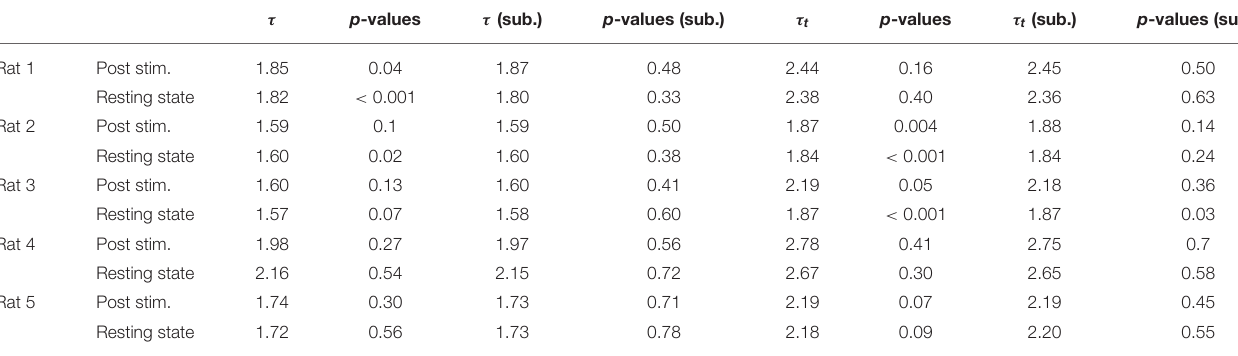
TABLE 2 | Exponents before ad after subsampling in MUAs data, with the corresponding p -values. τ p -values τ (sub.) p -values (sub.) τ t p -values τ t (sub.) p -values (sub.) Rat 1 Post stim. Resting state Rat 2 Post stim. Resting state Rat 3 Post stim. Resting state Post